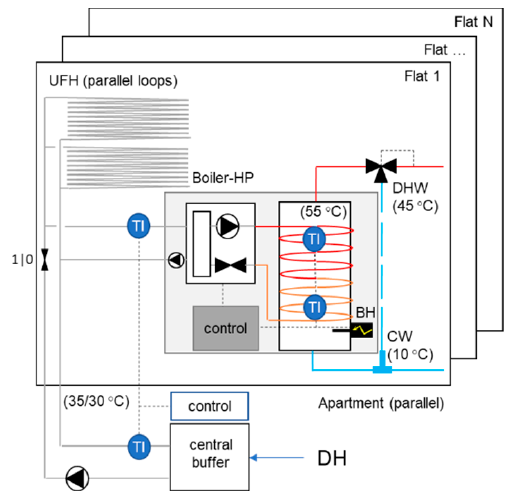
Figure 3. Simplified hydraulic scheme of a booster heat